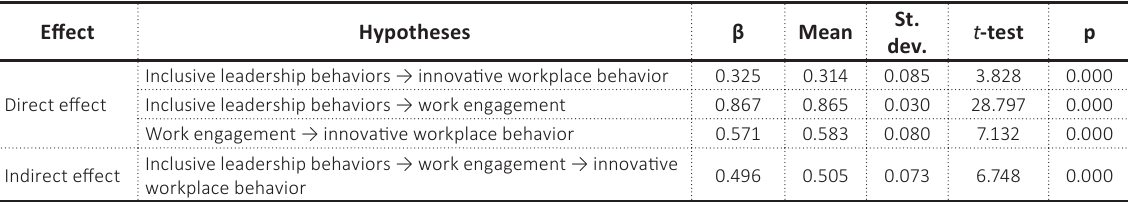
Table 5. Path coefficients, mean, st. dev., t -test, and p -values